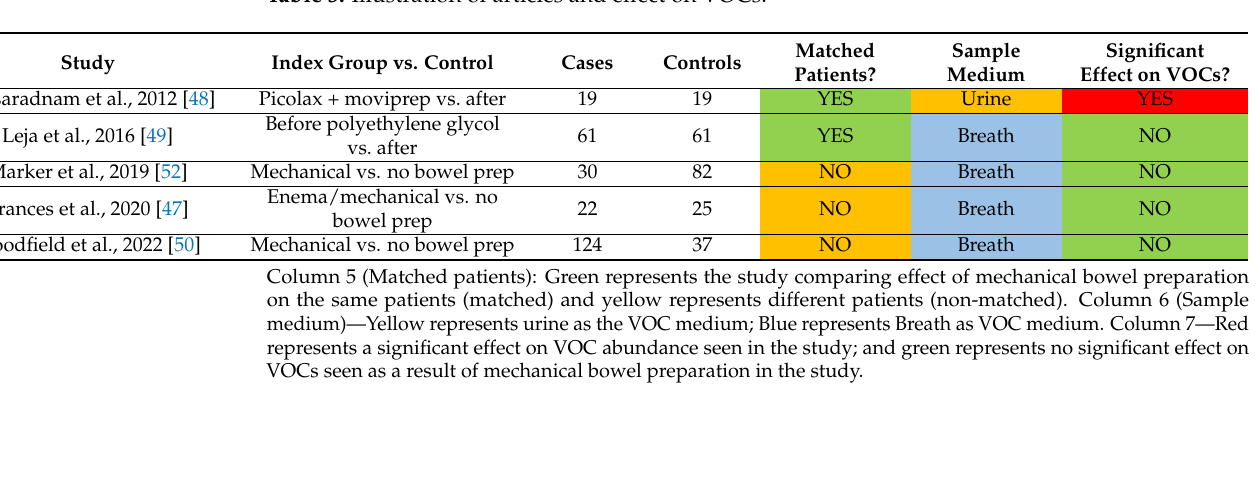
Table 3. Illustration of articles and effect on